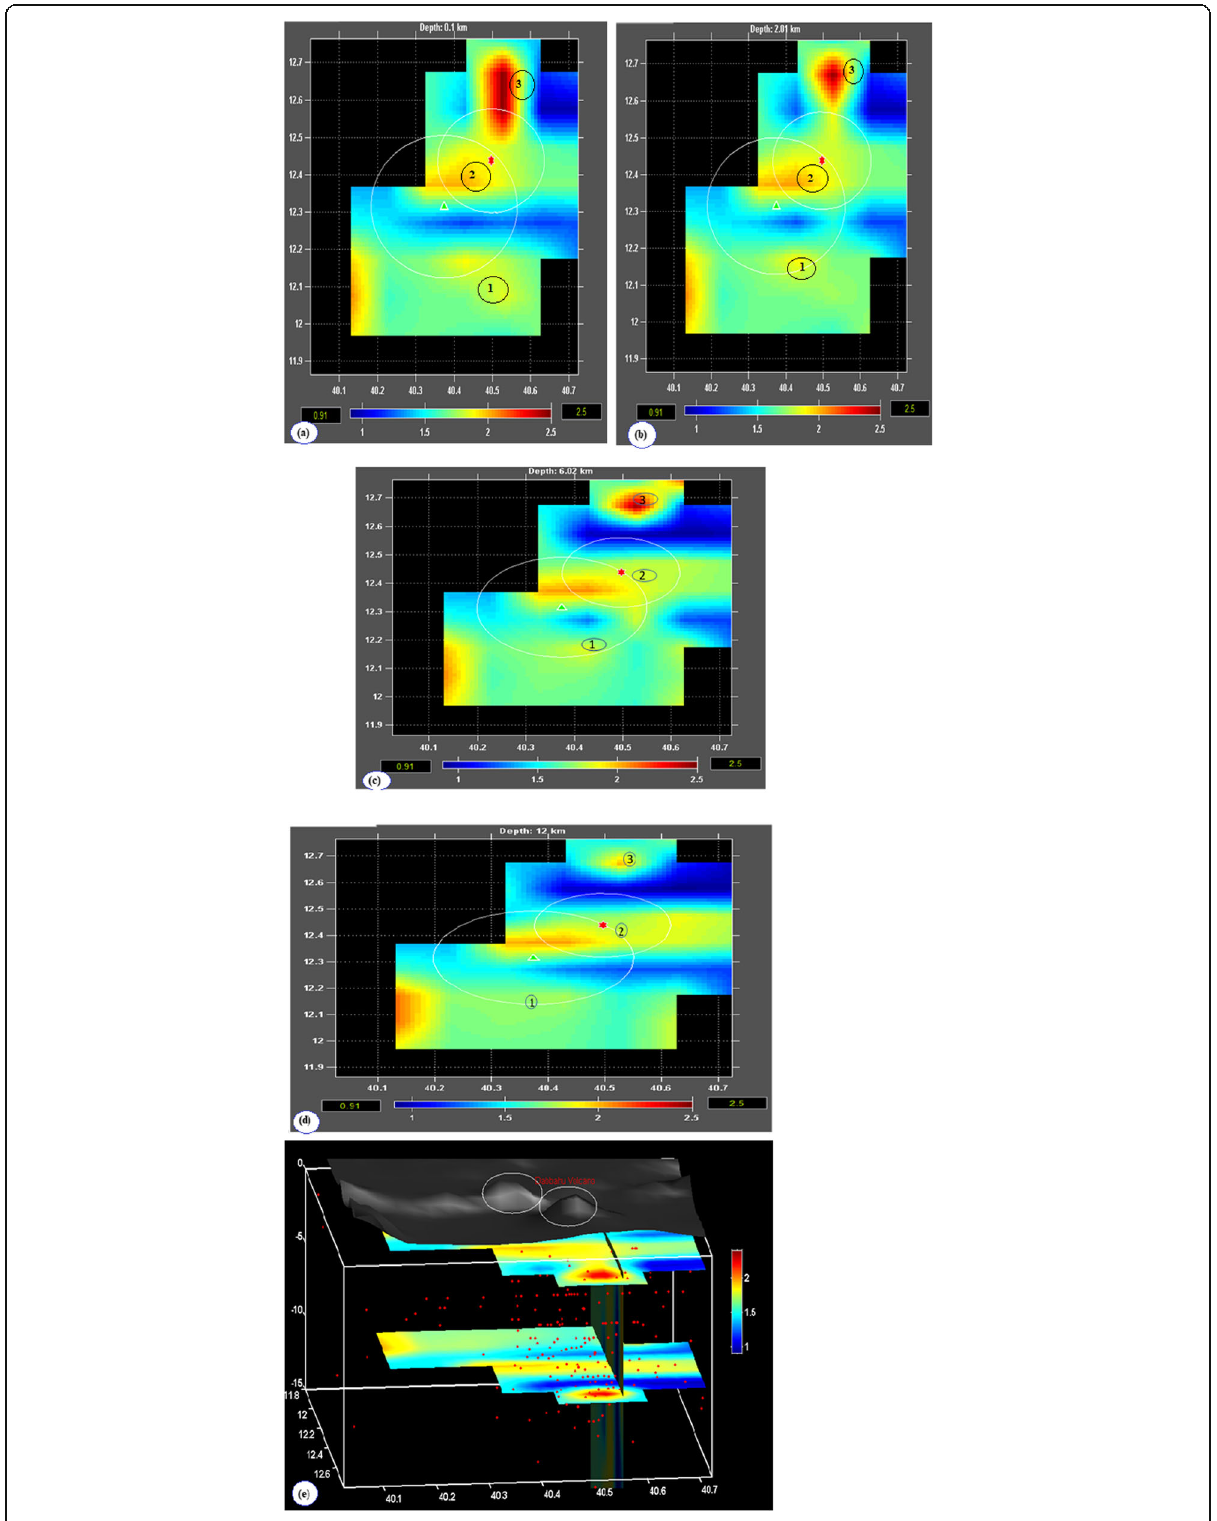
Fig. 9 Dabbahu Volcano: The depth Slices of b-value at depth of: ( a ) 0.1 km ( b ) 2 km ( c ) 6 km ( d ) 12 km ( e ) 3D b-value map of the Dabbahu Volcano, we can see the migration (depth and lateral variation) of the magma chambers beneath the Dabbahu Volcano showed in DEM on top indicated by the high b-values, the red symbol( (cid:129) )showed in this map is the EQ